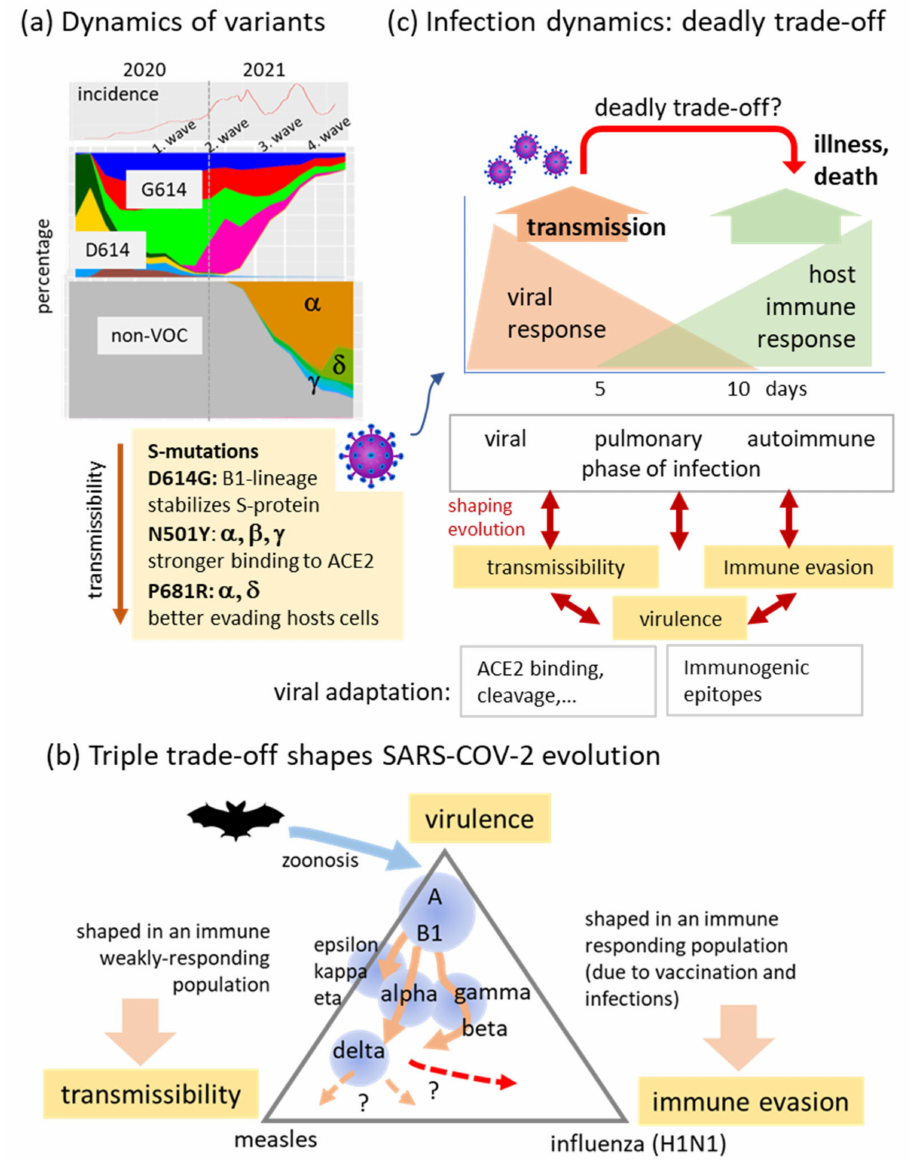
Figure 11. Understanding the past and predicting the future of COVID-19? ( a ) Dynamics of variants reflect a sequential ‘hostile takeover’ related mainly to increased transmissibility (infectiousness) after mutations of the spike protein: D614G made SARS-CoV-2 a bit more infectious thus promoting spread of the virus around the world causing the first wave of pandemic in 2020. The following waves of incidence relate to VOCs which replace each other often in serial order mainly due to increasing transmissibility. ( b ) Evolution of SARS-CoV-2 can be roughly understood in terms of a trade-off between three factors, virulence, transmissibility and immune evasion (reduced neutralization sensitivity): Zoonosis (presumably) from bat to humans causes the initial outbreak in Wuhan (A-lineage) followed by the spread over the world of B-variants and later in 2020 by mutational diversifications into VOI/VOCs mostly driven by increasing transmissibility but also affected by immunogenic adaptation. VOCs gamma and beta seem to better evade immune response than alpha and VOIs but all became virtually replaced by the highly infectious delta variant during 2021 [44]. Future developments are difficult to predict. Possible ways can lead towards further increasing transmissibility (measles-like behavior) or towards immune evasive variants (influenza-like, red dashed arrow). In an immune-responding population, the latter options seem more probably requiring repeated vaccinations to overcome escape variants. See text and [44] for a detailed discussion. ( c ) Evolution of SARS-CoV-2 can cause more severe variants if transmission from infected persons takes place before severe illness as observed for COVID-19 with an early viral response phase followed by pulmonary and later an autoimmune phase related to long-COVID and, in worst case, death